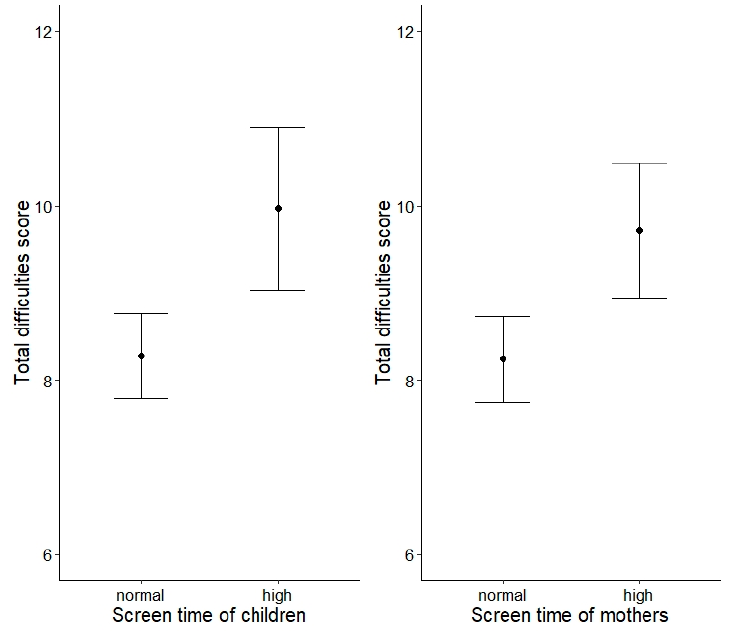
Figure 1. Effect plot (mean effect and 95% CI) illustrating the estimated total behavioral difficulties scores of children depending on screen time of children (on the left) and screen time of mothers (on the right).